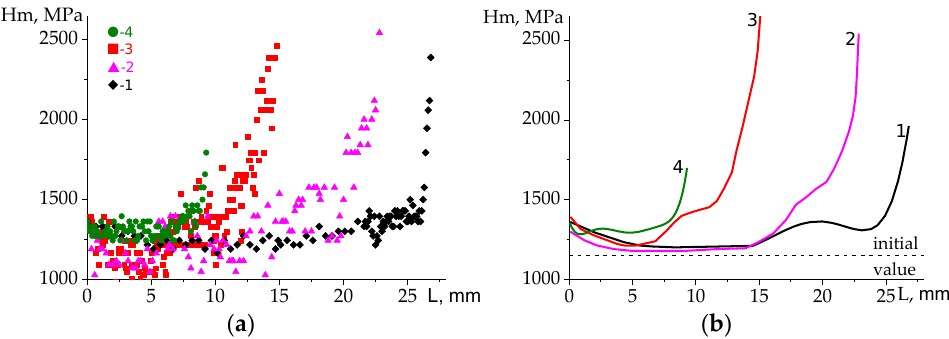
Figure 3. Microhardness ( a ) and calculated averaged microhardness ( b ) of the specimens for differ- ent impact velocities: (1) 162 m/s, (2) 225 m/s, (3) 316 m/s, and (4) 416 m/s. impact velocities: (1) 162 m/s, (2) 225 m/s, (3) 316 m/s, and (4) 416 m/s.